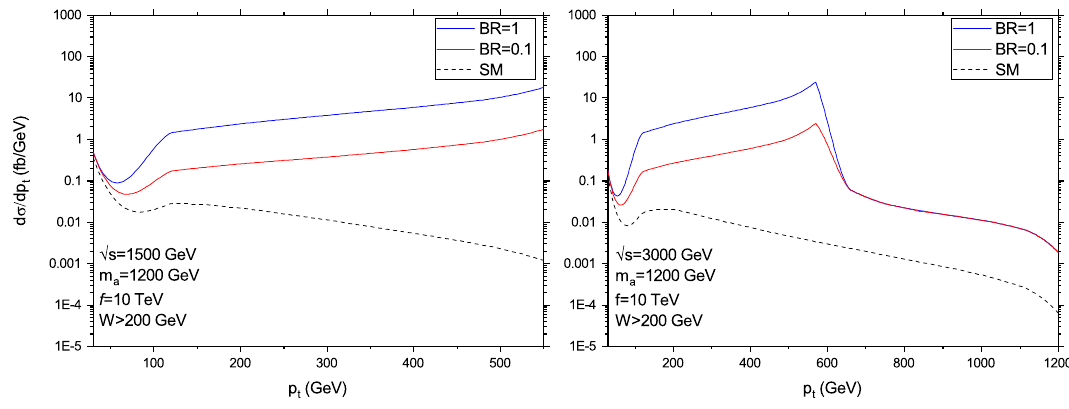
γγ at the CLIC for the CB initial → γγ ) = 1 . 0 and Br( a γγ ) = 0 . 1 are → →